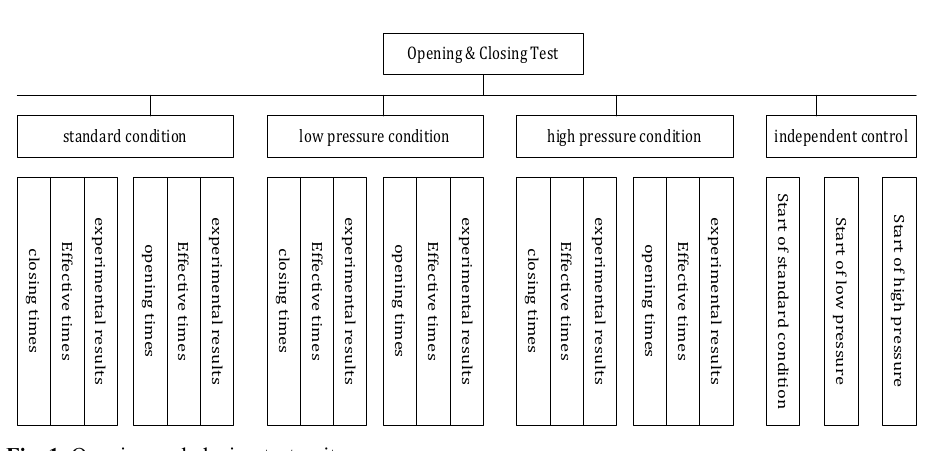
Fig. 1. Opening and closing test unit.